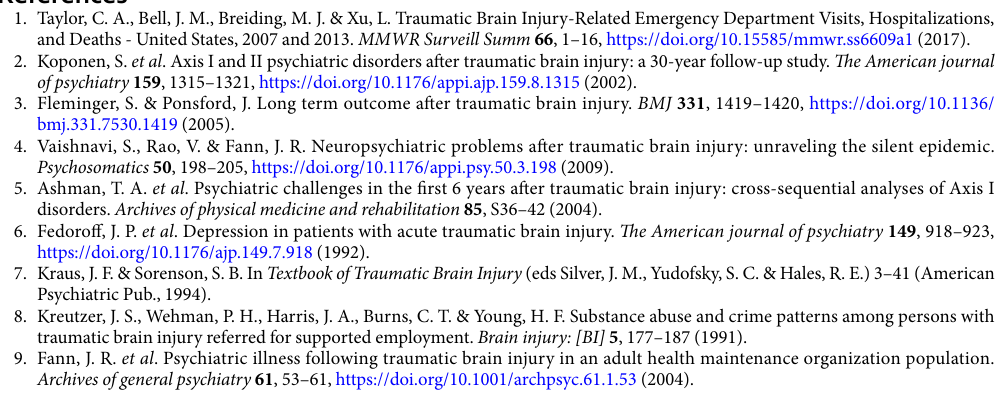
the most appropriate injury metric. Shockwave duration also influences injury onset and severity and should be accounted for in assessments of shockwave exposure 101 . Accordingly, the area under the positive overpressure versus time curve, also known as impulse magnitude, is often used to assess shockwave exposure severity. As such, impulse magnitude in the current study (80 kPa * ms) is in line with other studies incorporating shockwave exposures inside the shock tube. For example, Perez-Garcia exposed rats to 74.5-kPa with 4.8-ms duration shock- waves inside the shock tube and reported an impulse magnitude of 175.8 kPa * ms 99 . That study characterized